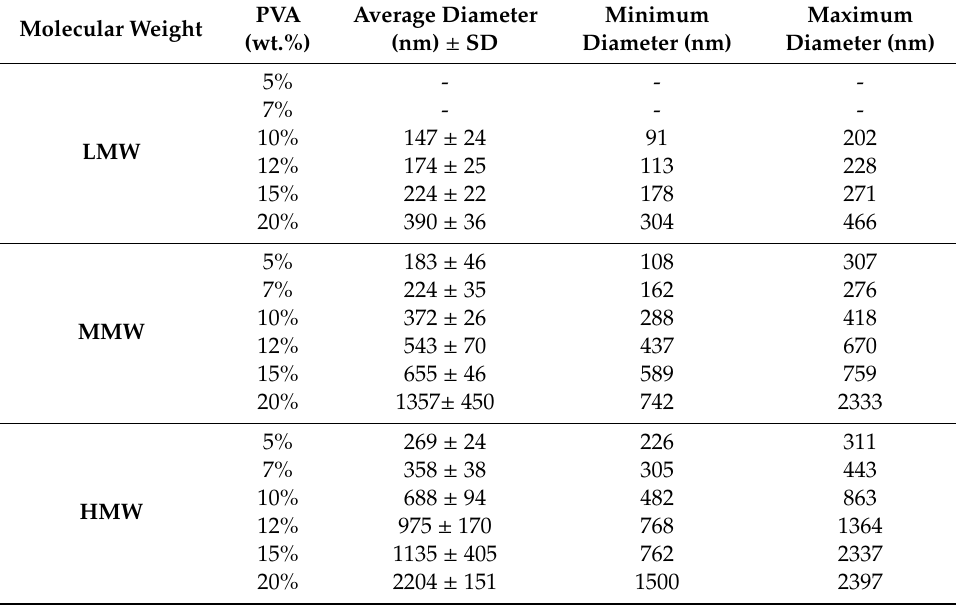
Table 2. Fiber diameters of the obtained electrospun fibers from pure PVA solutions. Molecular